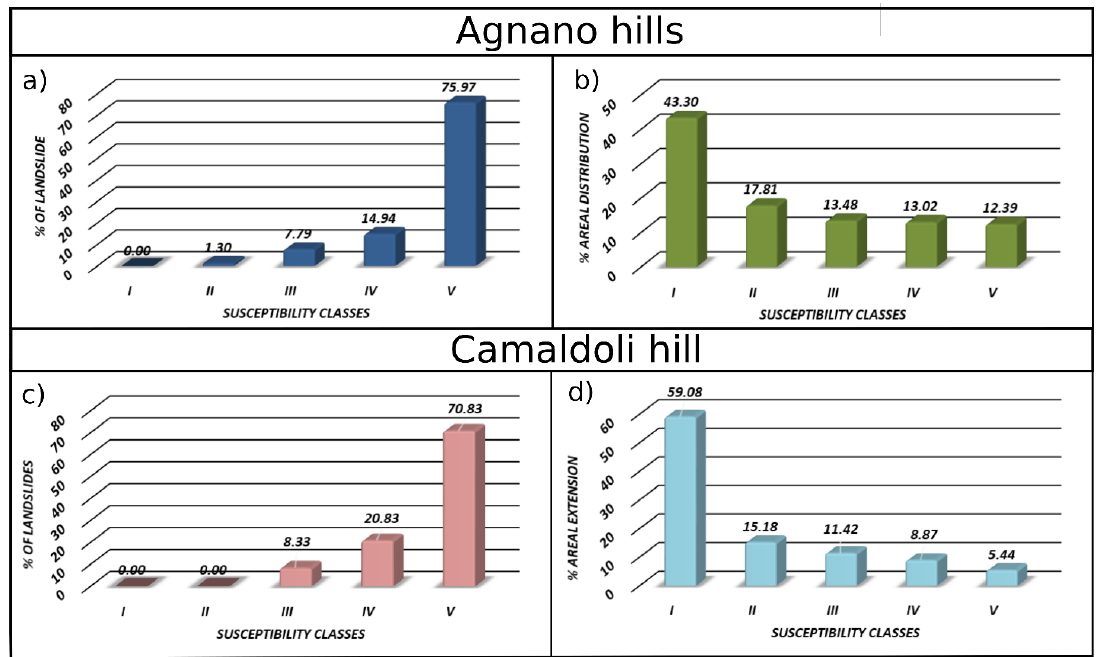
Figure 6. Landslide and areal extension distribution in susceptibility classes for the Agnano hills ( a , b ) and the Camaldoli hill ( c , d ).